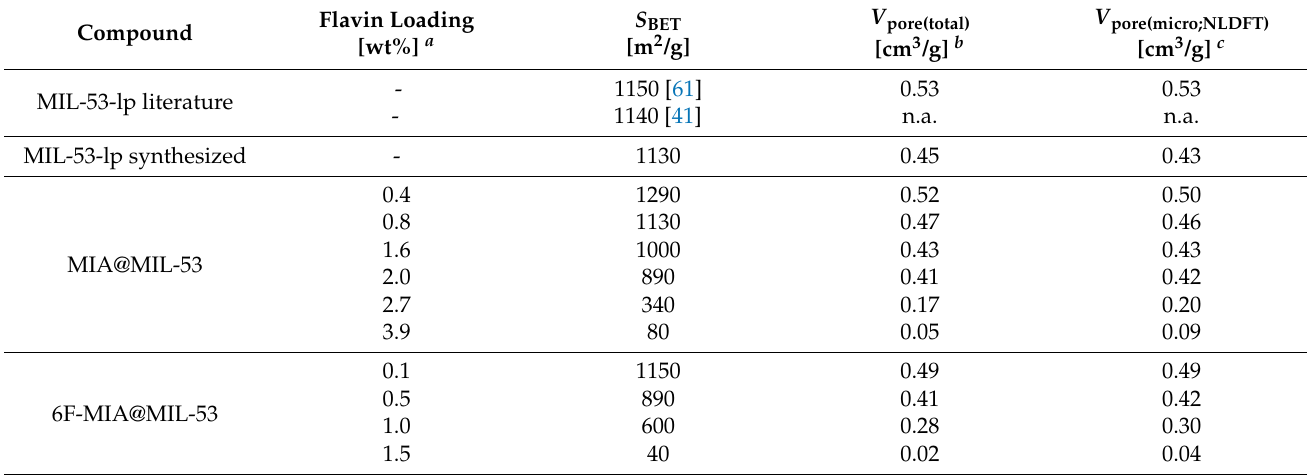
Table 1. Results of nitrogen sorption measurements for MIL-53 and